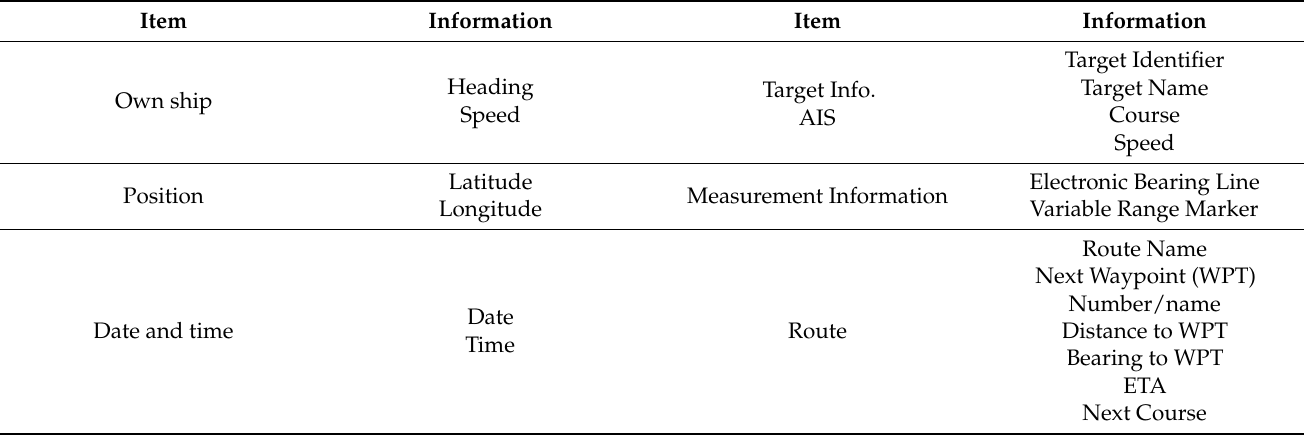
Table 8. Standardized information on GPS-plotter display based on the results of the user